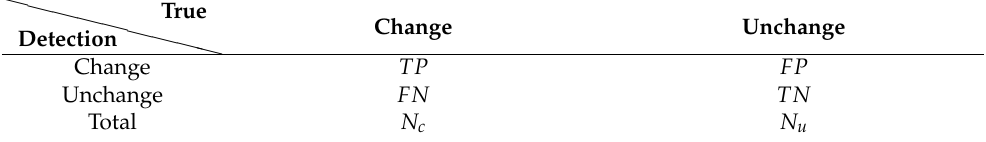
Table 1. Quantitative evaluation index of change